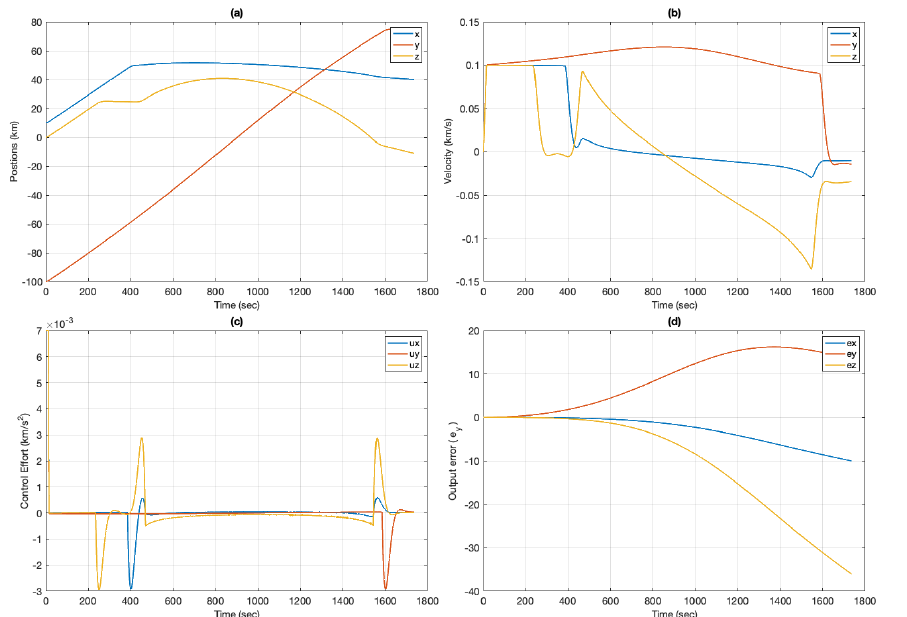
Figure 6. Plots for MPC feed–forward case for asteroid Kleopatra: ( a ) position vs. time; ( b ) velocity vs. time; ( c ) control effort vs. time; ( d ) output error vs.